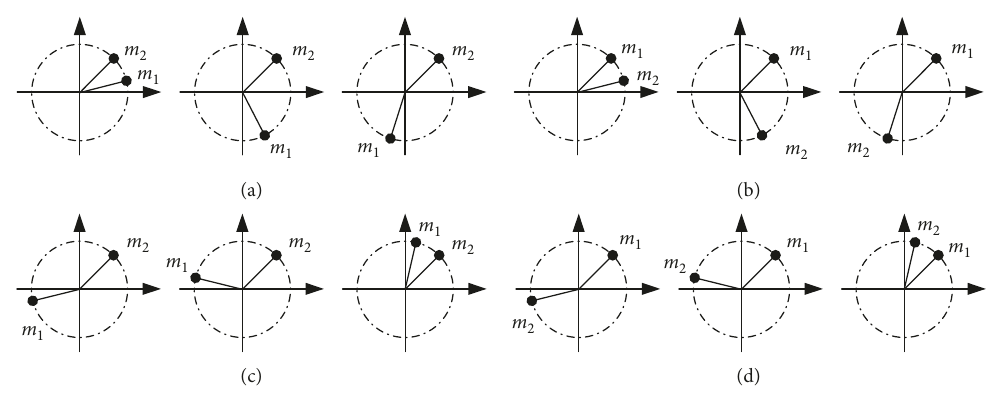
Figure 4: Change domain of the